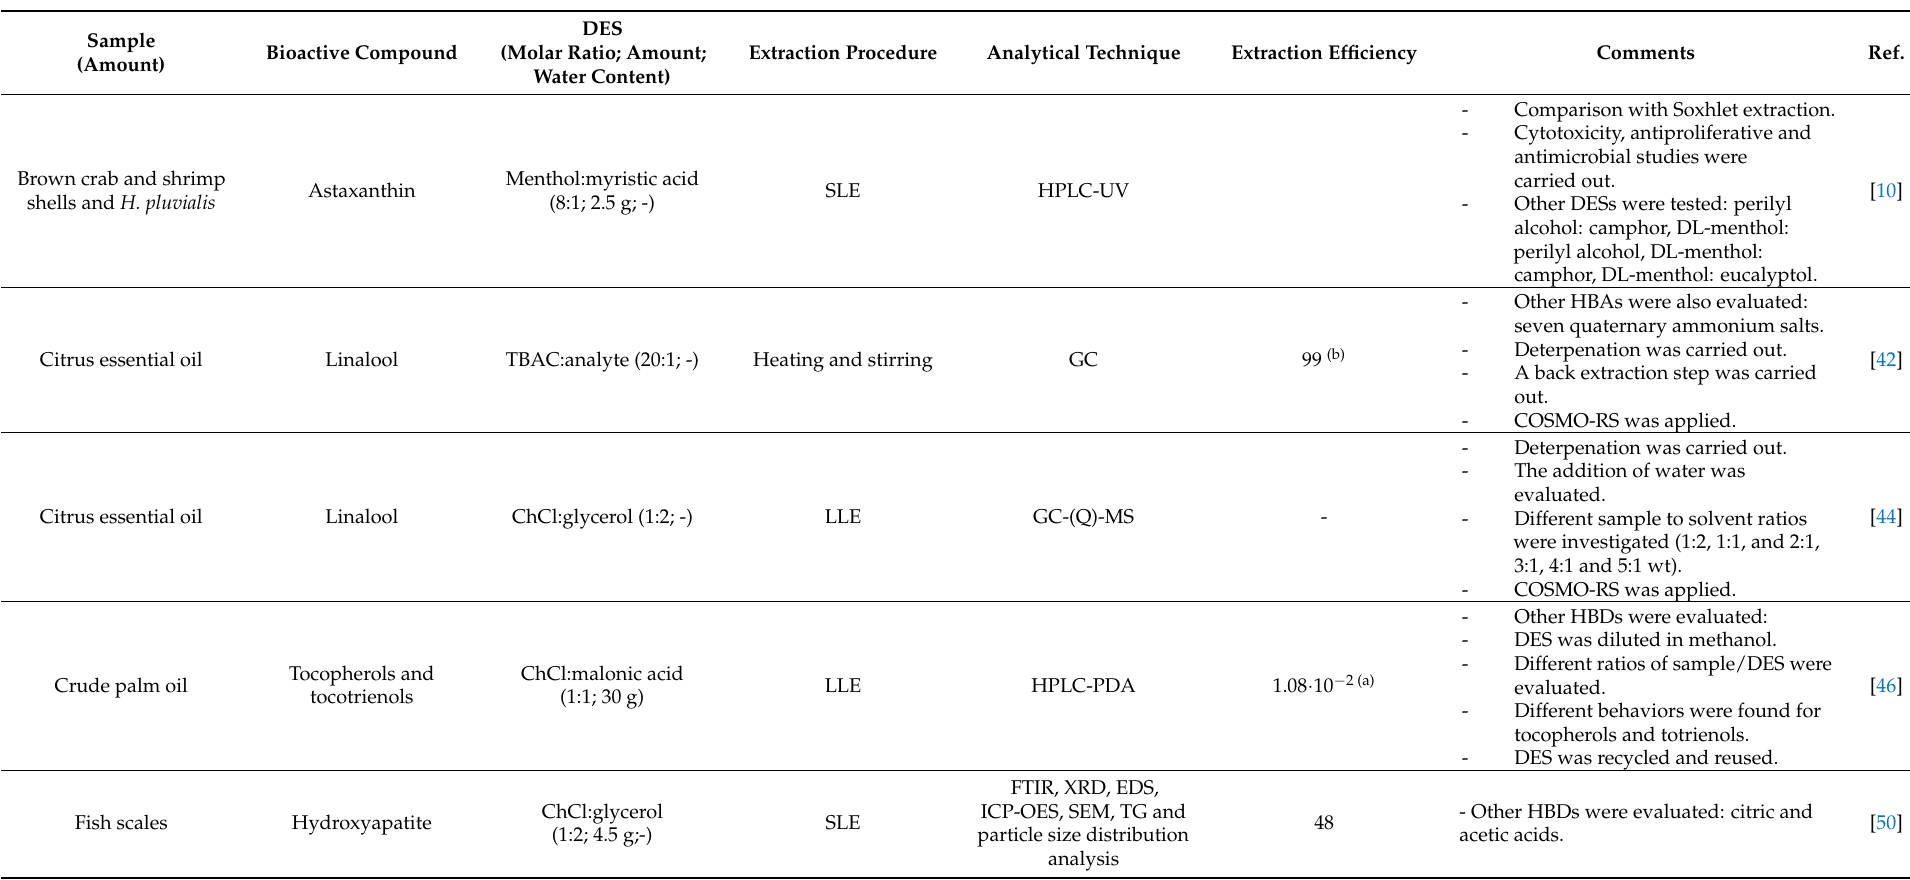
Table 3. Some examples of recent applications of DESs for the extraction bioactive compounds from other natural